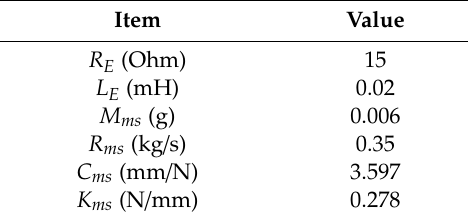
Table 2. Parameters of dynamic speaker unit.